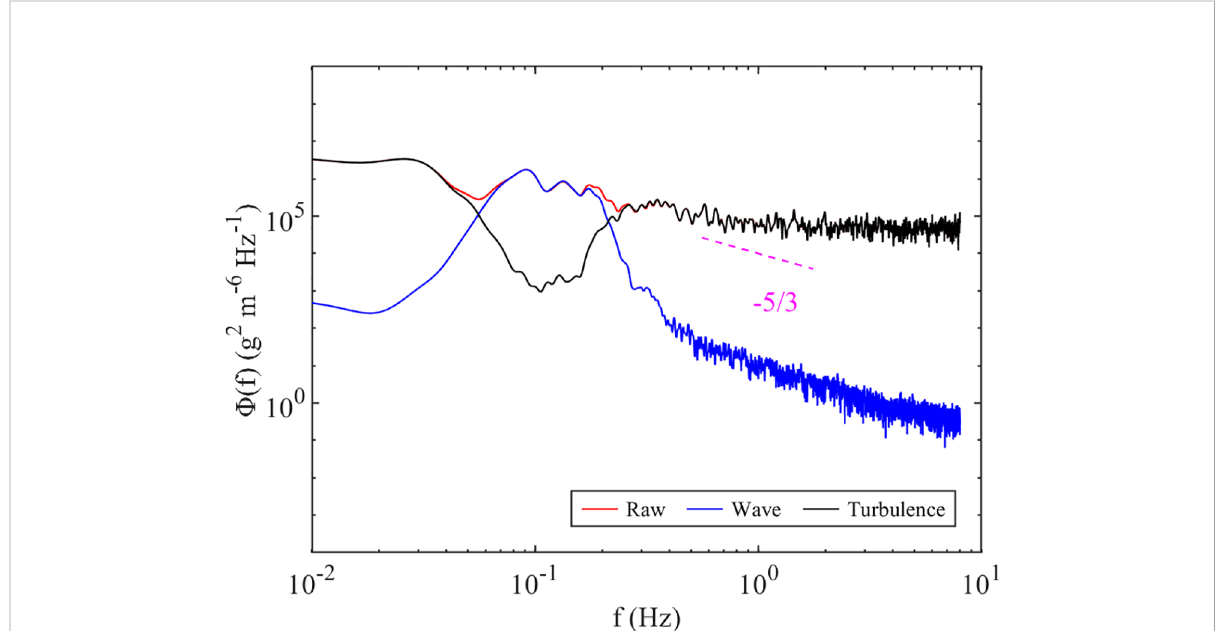
FIGURE 8 Power spectrum analysis of high frequency SSC fl uctuations, c ′ (red), and the decomposed fl uctuation that induced by wave ( c 0 w , blue) and turbulence ( c 0 t ,